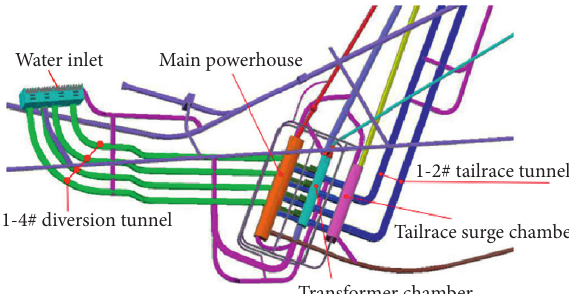
Figure 2: Layout of the underground cavern group at the Houziyan hydropower